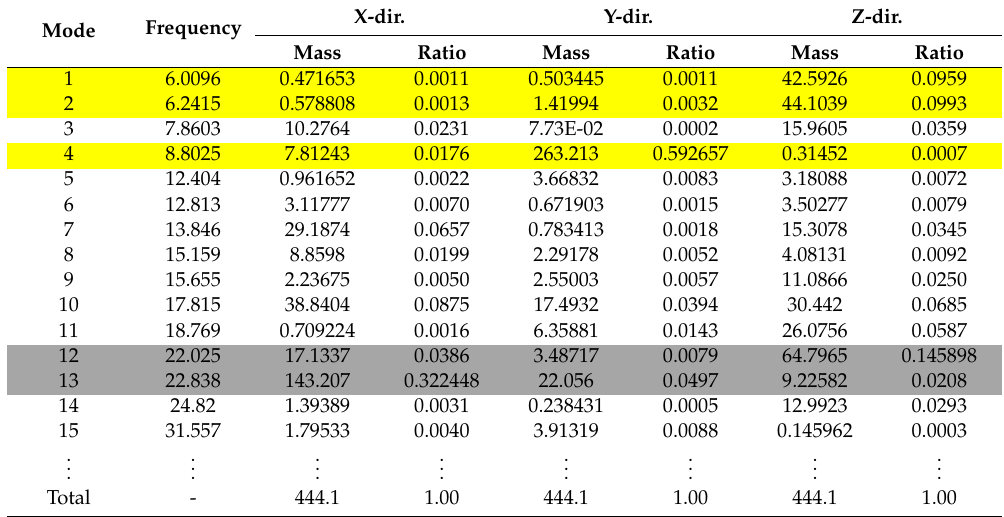
Table 2. Mode analysis result of the NUREG / CR-1677 Benchmark piping